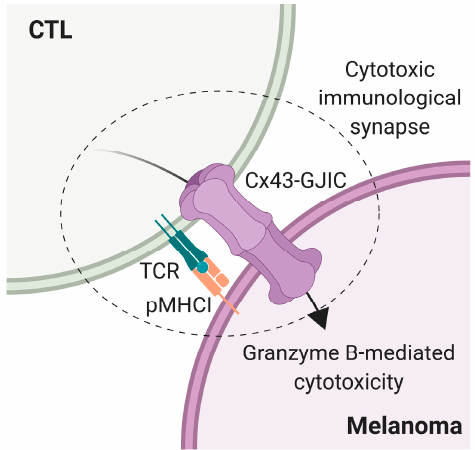
Figure 5. Model of connexin-43 (Cx43)-gap junction (GJ) intercellular communication (Cx43-GJIC) in the cytotoxic T lymphocyte (CTL)-mediated melanoma cell killing. Upon cytotoxic immunological synapse formation, initiated by T cell receptor (TCR)-cognate antigenic peptide-MHC I (pMHCI) interaction, Cx43-GJ channels polarize to the CTL-melanoma cell contact site, allowing Cx43-mediated cell coupling and the efficient activity of CTL-derived granzyme B on the target tumor cell.